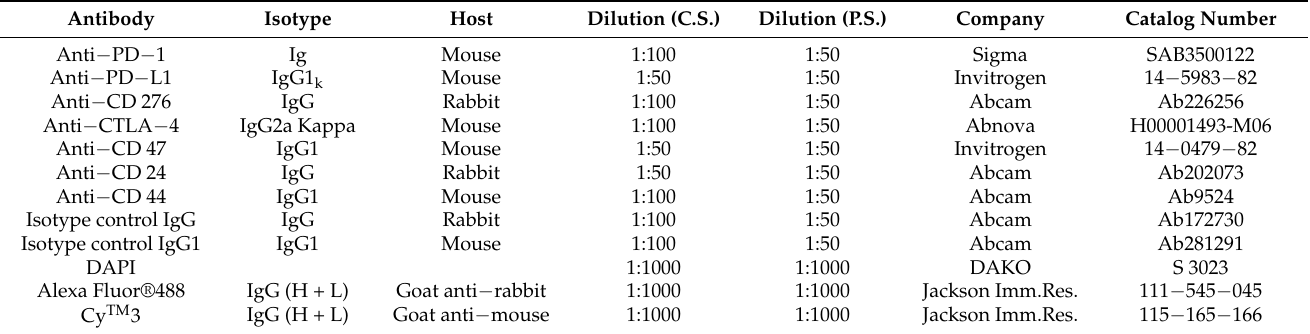
Table A1. Antibodies employed for chamber slides (C.S.) and paraffin sections (P.S.).